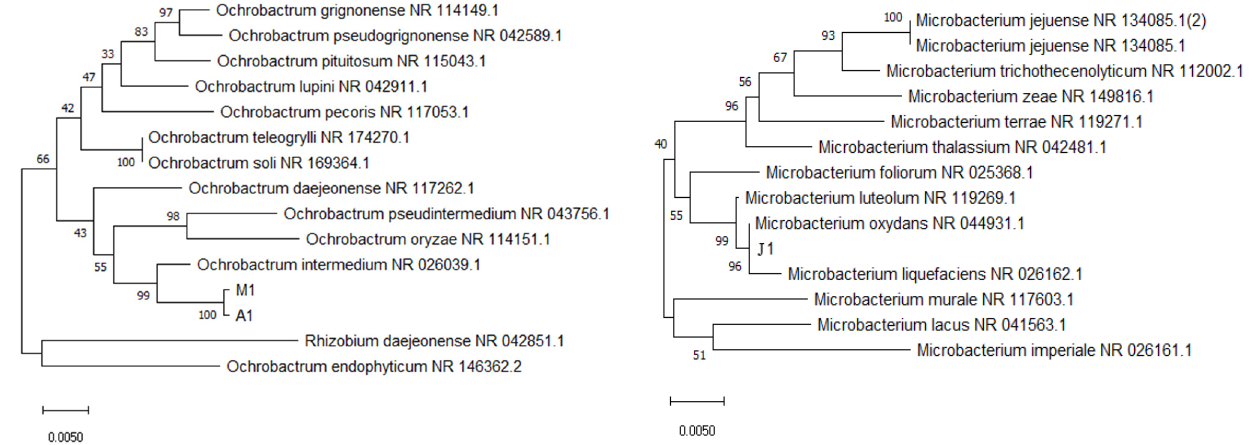
Figure 1. Neighbor-joining phylogenetic tree of the representative bacterial strains A1, J1, and M1, and their related species based on the 16S rRNA gene sequences.